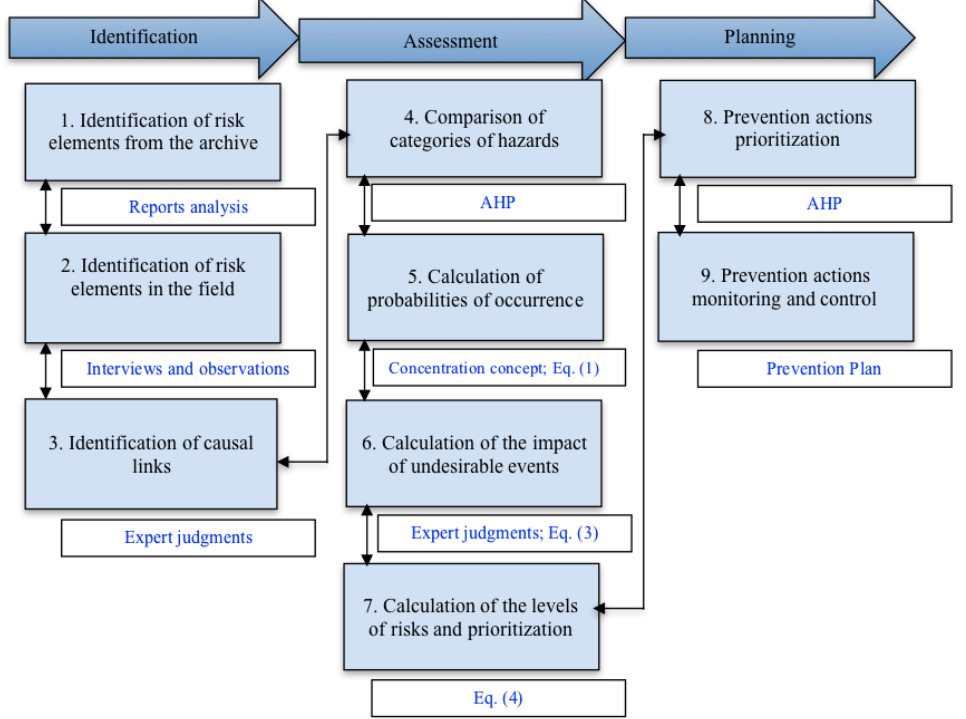
Figure 2. Details of the proposed approach based on risk factors.